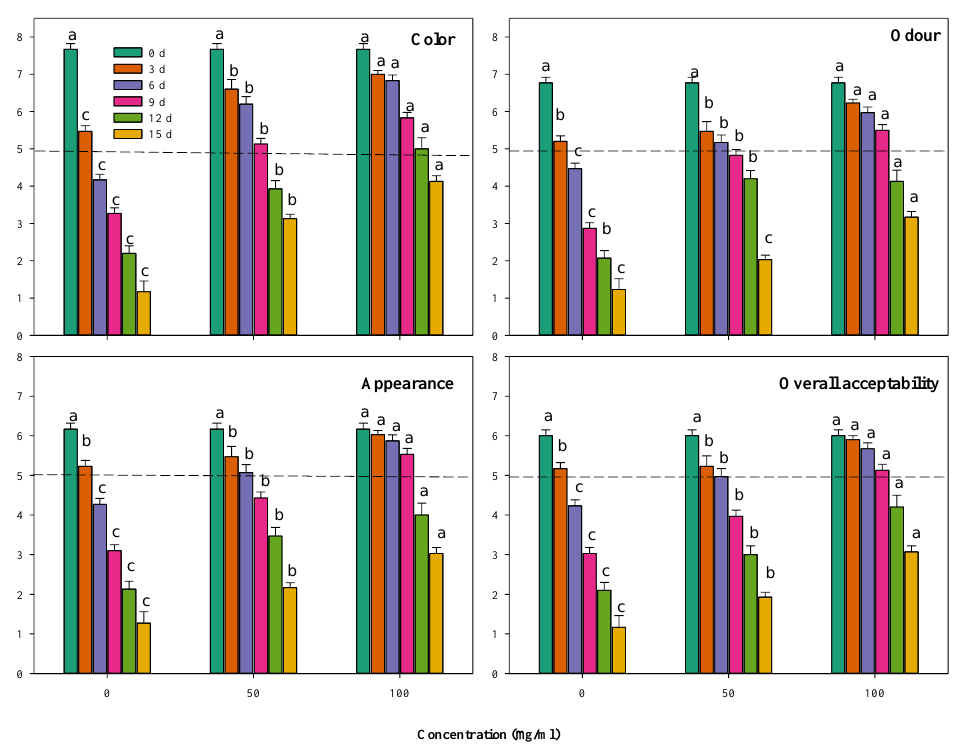
Figure 5. Storage changes in the sensorial properties of minced beef combined with catfish glycoprotein (CFG) at di ff erent levels (0, 50 and 100 µ g g − 1 ) during 15 days storage at 4 ◦ C. Every value is the average of ten replicates ± SD. The dashed line represents the border under which the sensorial quality is considered unacceptable. Di ff erent letters for the same time storage (same column color) refer to significant di ff erences ( p <